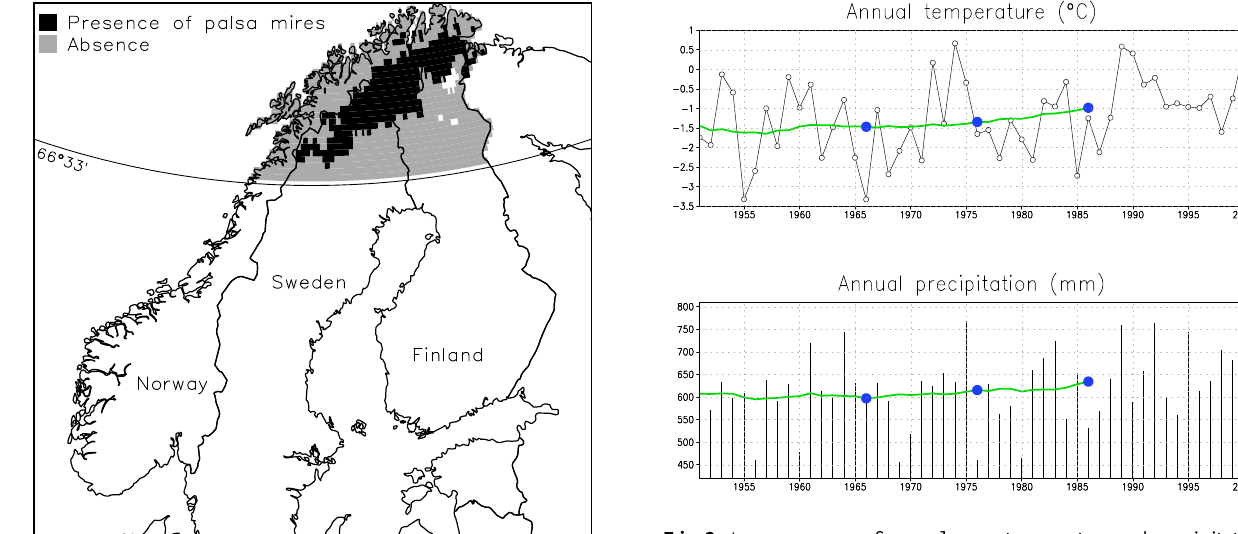
Fig. 2. Area-averages of annual mean temperature and precipitation (black lines), running 30yr-averages centred at their mid-yr (green lines) and period-averages for 1951–1980, 1961–1990 and 1971– 2000 (blue points) for the European land grid cell north of the Arctic Circle (66.5 ◦ N) of the CRU TS 2.02